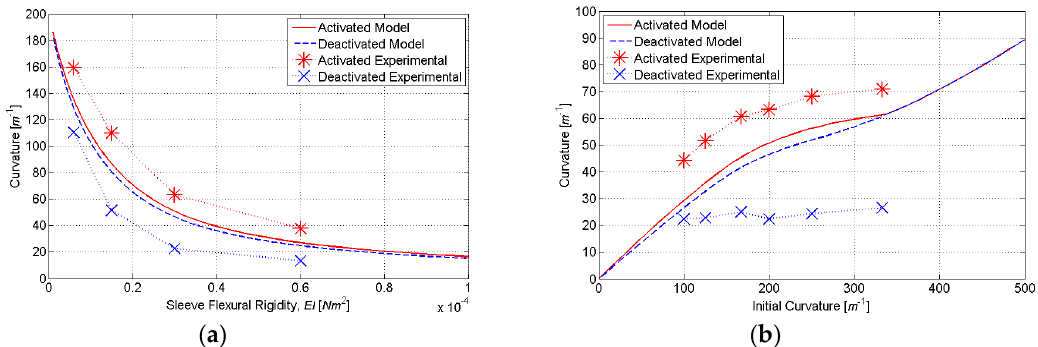
Figure 14. Predicted vs. experimentally measured actuator curvatures for the initial (non-optimized) model: ( a ) as a function of the sleeve flexural rigidity EI , ( b ) as a function of the initial curvature κ 0 .